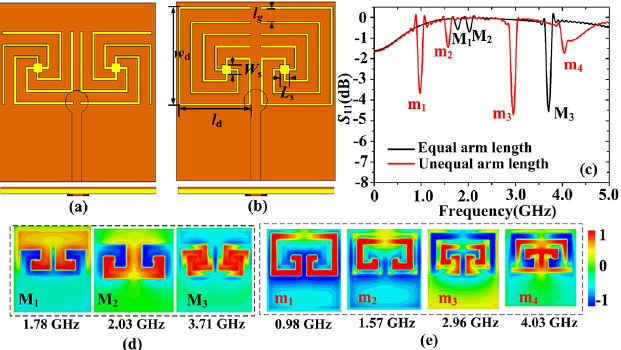
Fig. 4. Top view and side view of the complementary MSS with (a) equal arm length and (b) unequal arm length. (c) Simulated re fl ection coef fi cients of the complementary MSSs. (d) The simulated 2D E z - fi eld distributions on the plane located 1 mm above the complementary MSS with equal arm length. (e) The simulated 2D E z - fi eld distributions on the plane located 1 mm above the complementary MSS with unequal arm